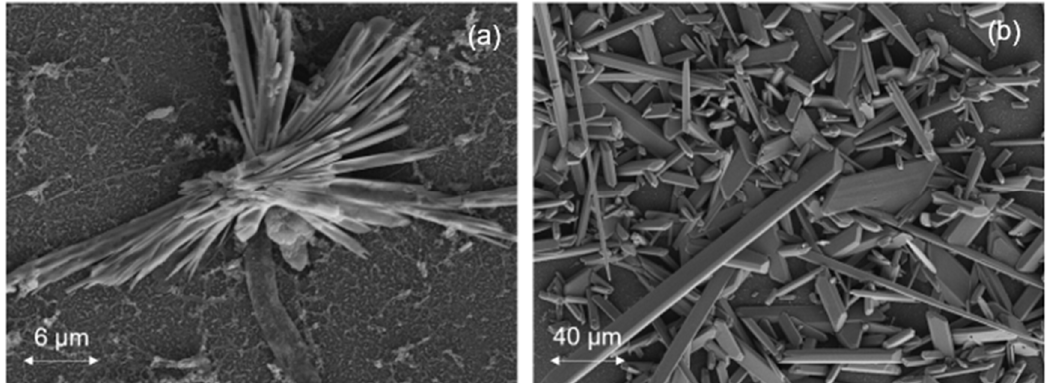
Figure 3. SEM images of scaled membrane surfaces revealing different gypsum crystal structures: ( a ) rosette arrangement (on Dow SW30 membrane) consisting of gypsum platelets extending from a core region and ( b ) individual needle-shaped platelet structures (on Toray SWRO membrane) (images are at the end of the 24 h scaling tests).